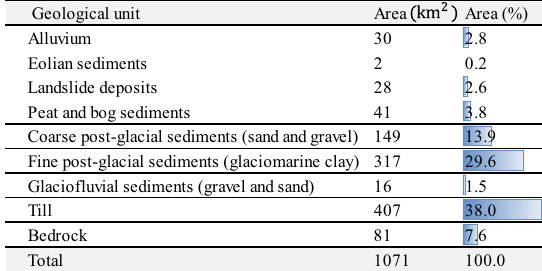
Table 4 Major Quaternary units and respective coverage of the study